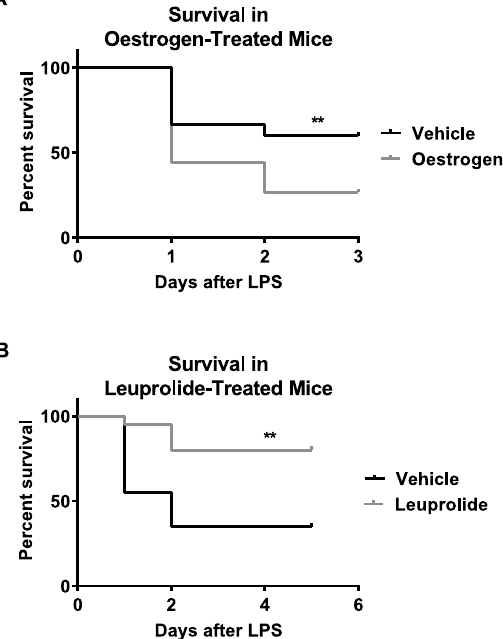
Figure 5. Delay or expedition of puberty by hormonal treatment alters mortality from endotoxemia. ( A) Pre-pubertal CD-1 mice were pre-treated with daily subcutaneous injections of 17 β -Oestradiol at 100 μ g/ ml or vehicle (0.4% DMSO) suspended in corn oil for three days prior and once on the day of intraperitoneal E. coli endotoxin injection. Per cent survival over three days was recorded (N = 45/group). (B) Pre-pubertal C57Bl/6 mice were treated with daily subcutaneous injections of leuprolide at 250 μ g/ml or vehicle (0.9% sodium chloride) starting on PND 24 and continuing until post-puberty (PND 35) before S. enterica endotoxin injection (N = 20/group). Per cent survival over three days was recorded. Significant differences in survival between pre- and post-pubertal mice are labelled ** (p < 0.01). Per cent survival was compared using a log rank Mantel Cox